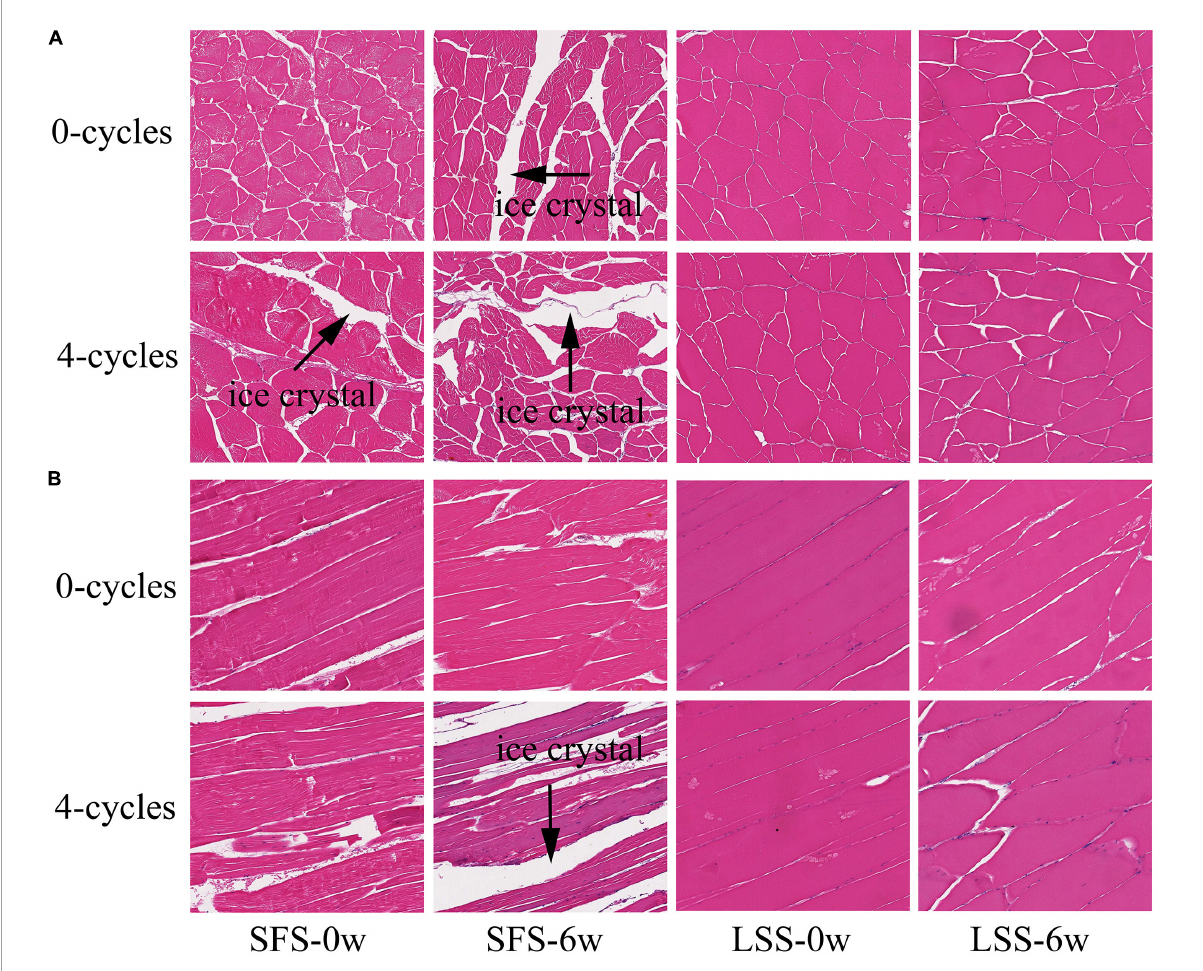
FIGURE6 Structural observation of LYC. SFS and LSS represent the salt-free soaking group and low-salt soaking group, respectively. Panels (A,B) showed the cross-section and vertical-section, respectively. The magnification of images is 10